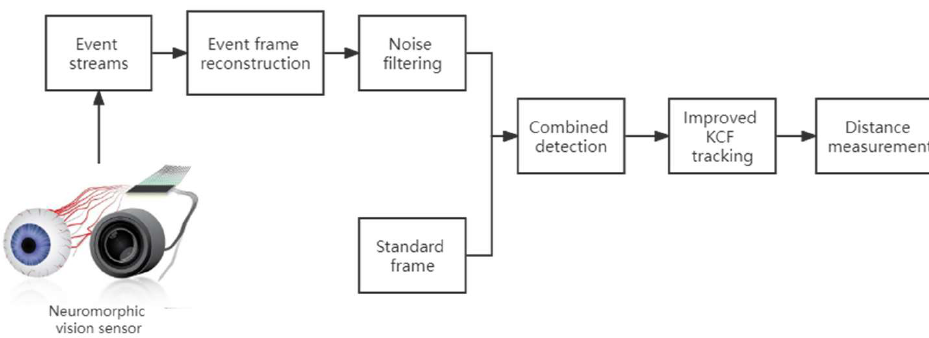
Figure 2. Example of object detection and tracking.